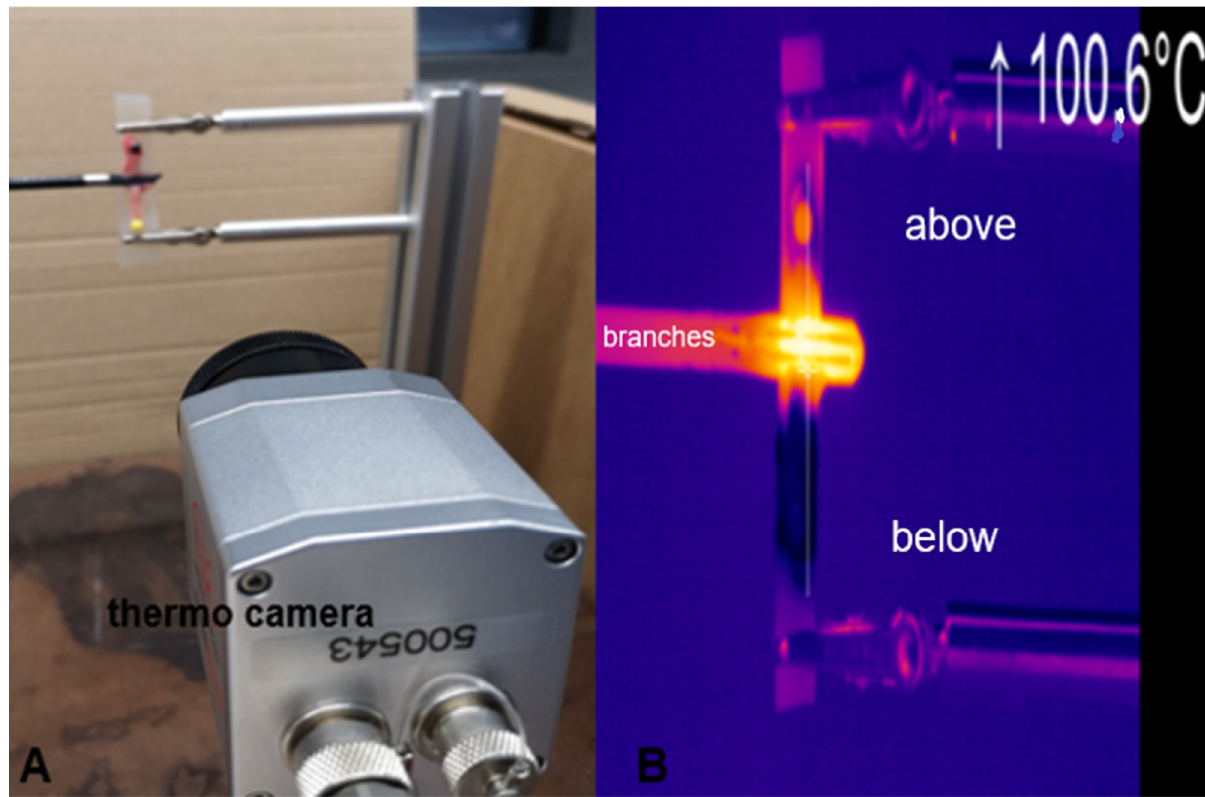
Figure 1. ( A ): Experimental setup, with the position of the thermal camera towards the sealed vessel ( B ): Example of a measurement by thermal camera (own pictures).